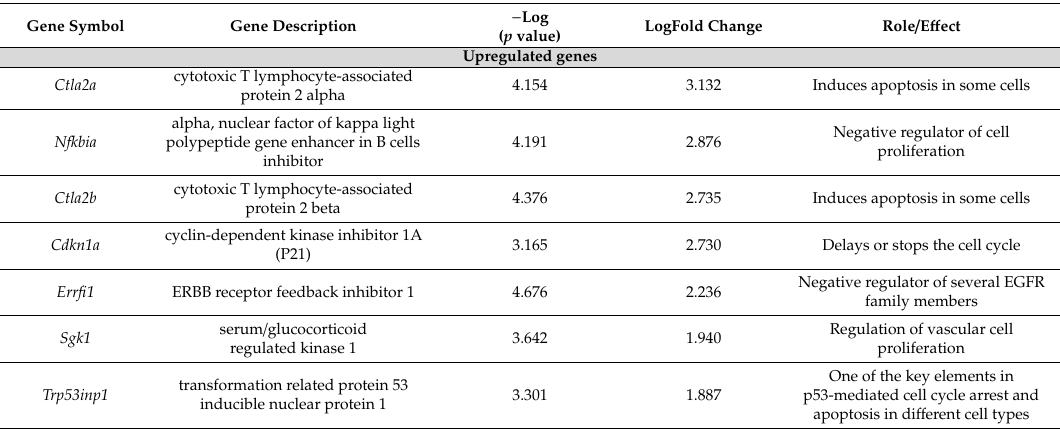
Table 2. Top 20 upregulated genes detected in brain hemispheres 24 h after the administration of